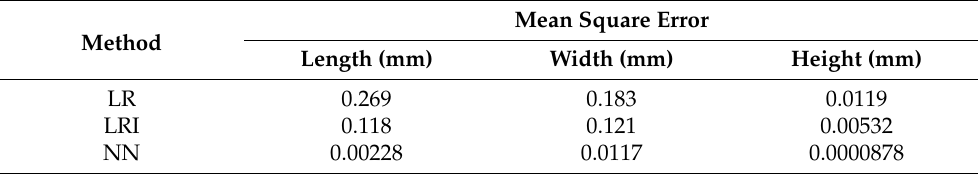
Table 7. MSE results.